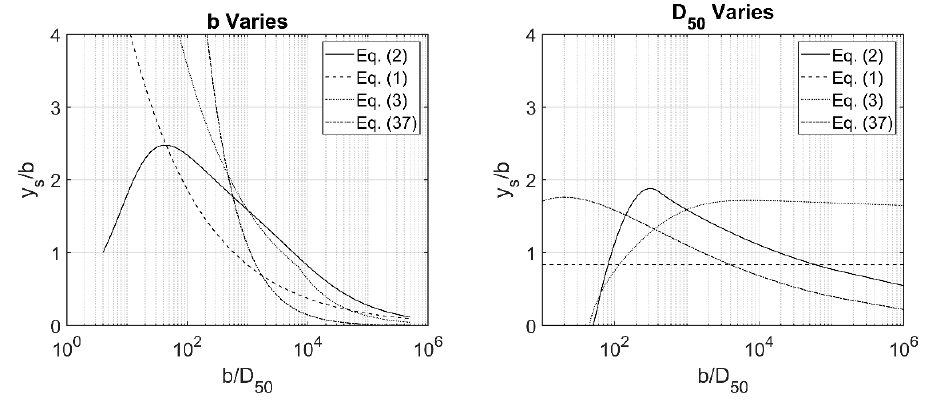
Figure 5. Plots of Equation (37) for various 𝑉 (cid:3042) values.